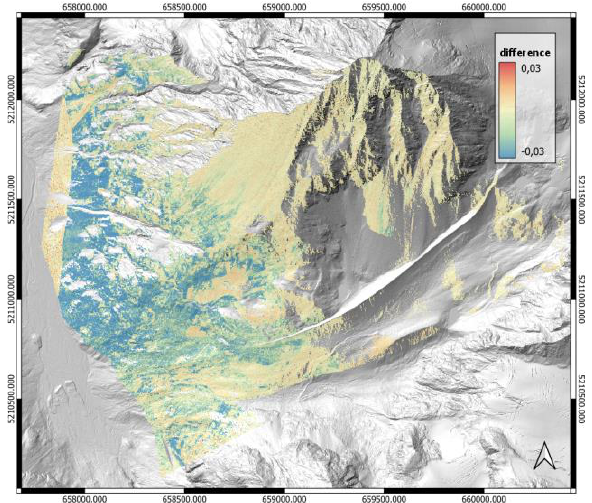
Figure 11. Difference between October emissivity mean and August emissivity mean.